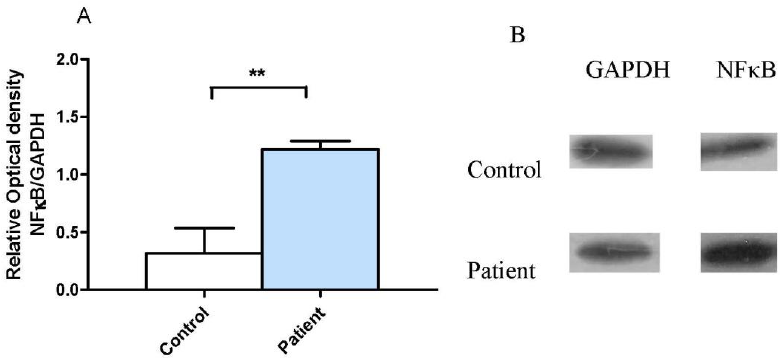
Figure 4. Expression of NF-κB in neocortical tissue of patients with drug-resistant temporal lobe epilepsy. ( A ) Comparison of relative optical density values of NF-κB in patients and control subjects. ( B ) Representative example of the immunodetection of NF-κB in a patient and a control, as well as for GAPDH. The bars represent the mean ± the standard error of the mean, t -Student test, ** p ≤ 0.001